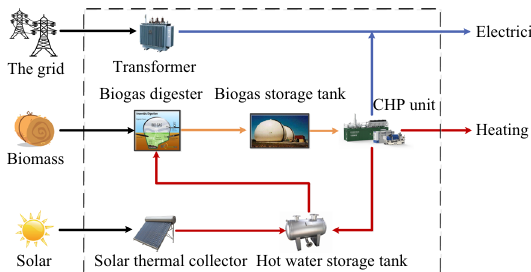
Fig. 3 Solar-boosted biogas generation system for multi-energy